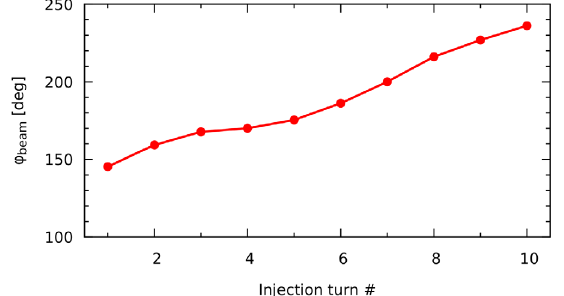
FIG. 10. Beam phase with respect to a reference rf signal measured in HEBT as a function of the injection turn number into the accumulator ring. The disabled SRF cavities are kept in resonance with the beam. Each point is the beam phase averaged over a time period corresponding to a single injection turn.